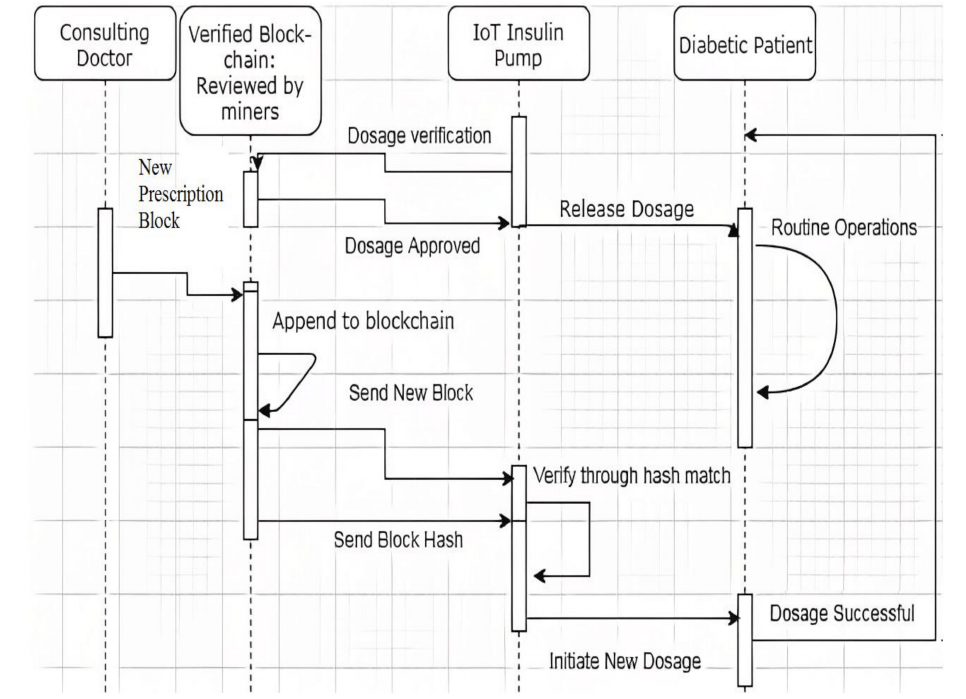
Figure 2. Working sequence of the Blockchain IoT